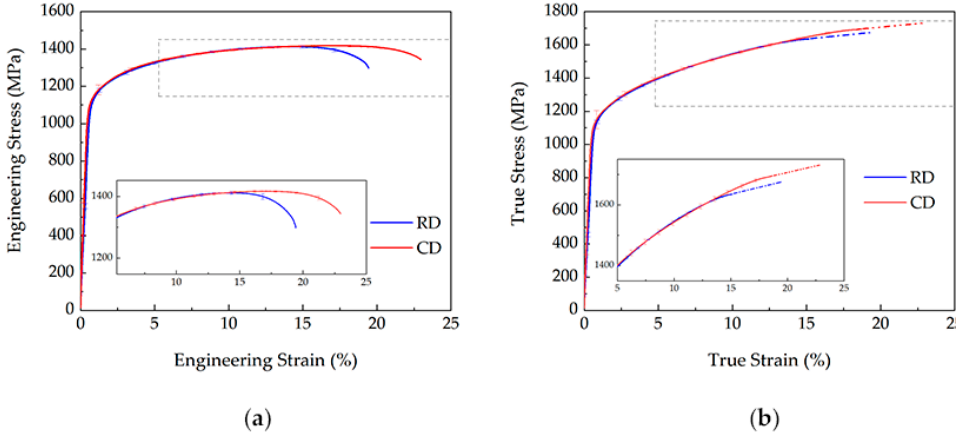
Figure 3. The engineering ( a ) and ( b ) true stress–strain curves of the tensile test along CD and RD.